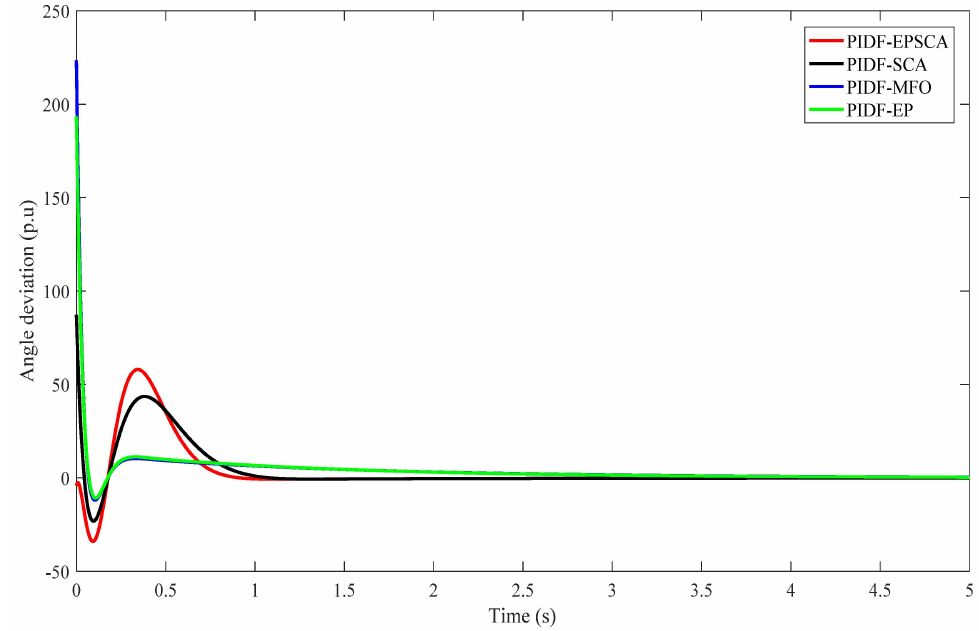
Figure 18. Angle deviation response of the TCSC-PIDF controller using PIDF-EPSCA, PIDF-SCA, PIDF-MFO, and PIDF-EP techniques for Scenario A-2.